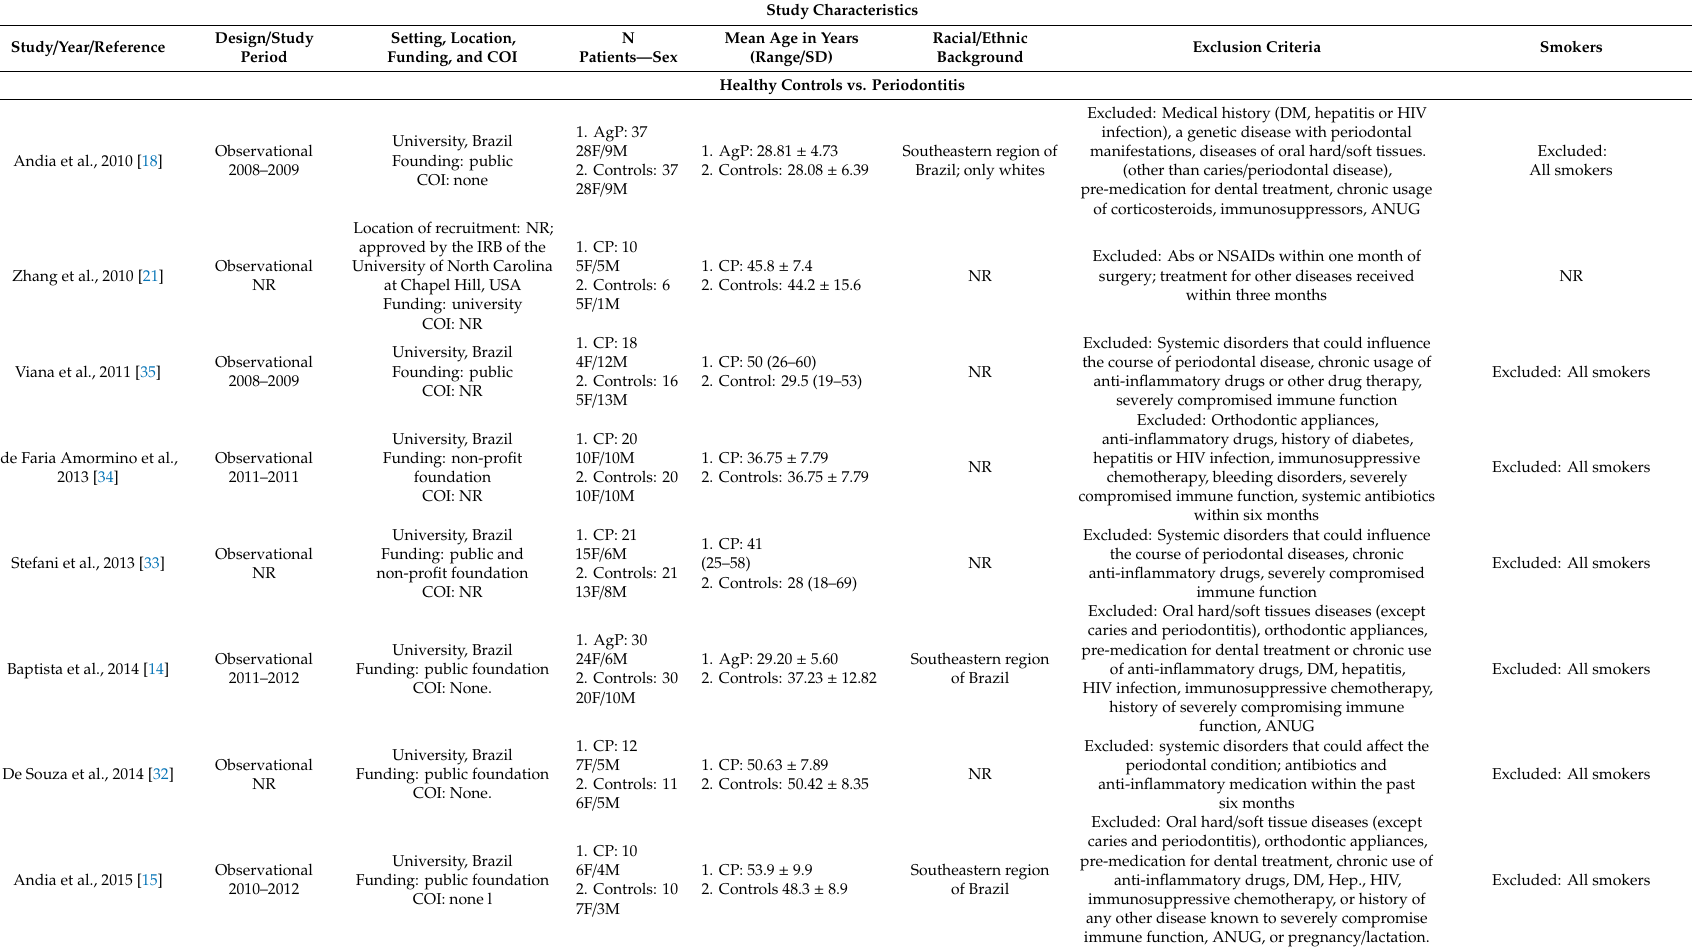
Table 1. Characteristics of the included